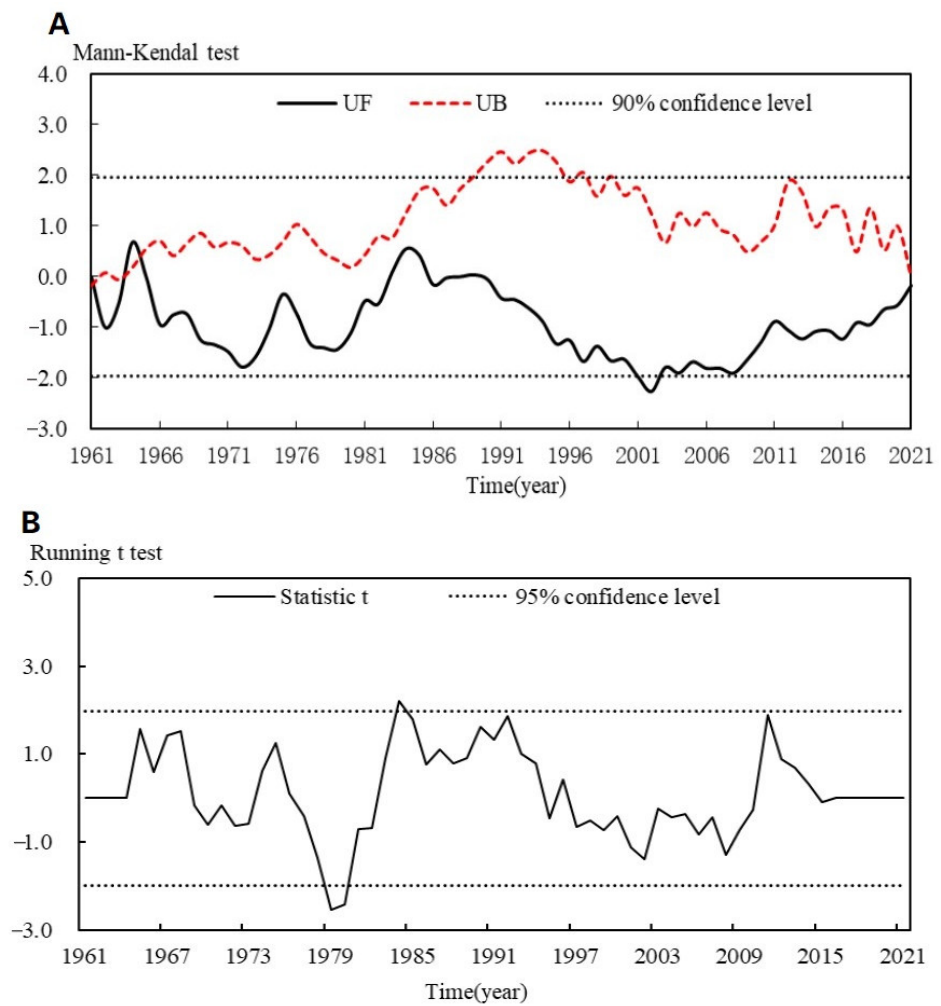
Figure 8. As in Figure 7, but for DR.